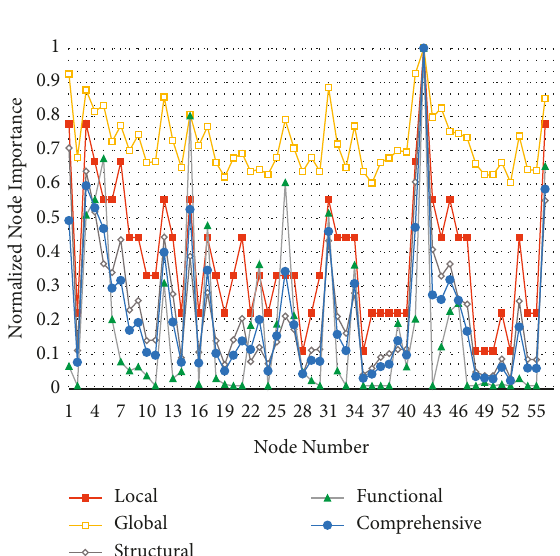
Figure 2: Node importance results of various measurements which are presented in different